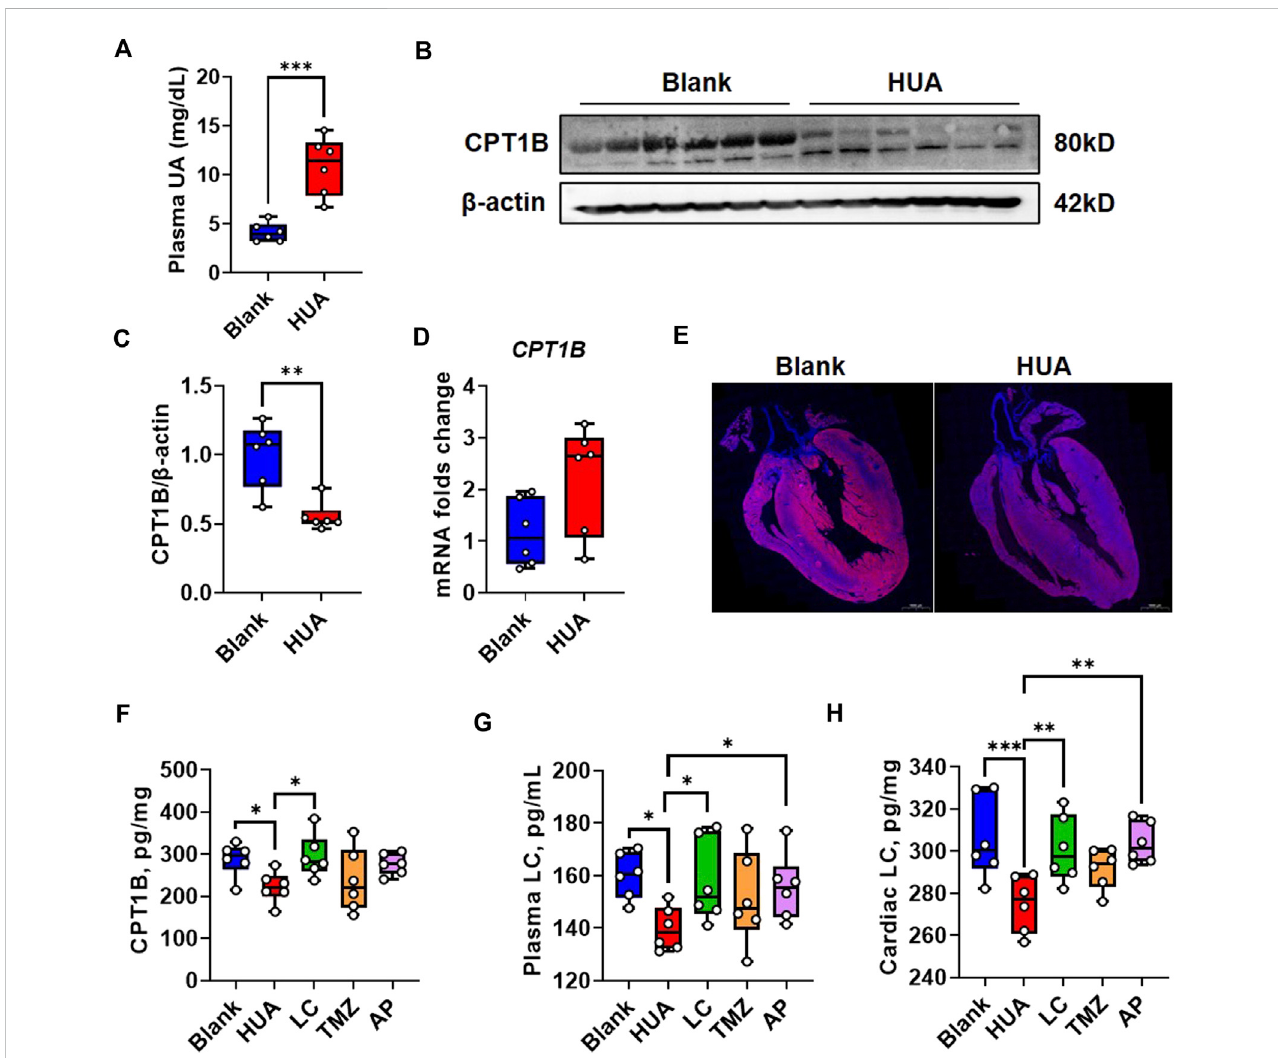
FIGURE 5 CPT1Bresponseinearly-stageHUAmice. (A) TheUAconcentrationinplasmaofblankandHUAgrouprespectively( n =6); (B) TheproteinlevelofCPT1B intheheartsamplesfromblankandHUAgrouprespectively, β -actinwasusedasaninternalloadingcontrol; (C) Thequanti fi cationofFigure5B; (D) ThemRNA folds change of CPT1B in the heart samples from blank and HUA group (n = 6); (E) The immuno fl uorescence re fl ects the distribution of CPT1B in the heart samples from blank and HUA group respectively. DAPI indicates nuclei, scale bar = 1000 μ m; (F) The protein level of CPT1B in heart samples by ELISA quanti fi cation(n=6); (G) TheplasmaLCconcentrationsbydifferenttreatment( n =6); (H) ThecardiacplasmaLCconcentrationsbydifferenttreatment( n